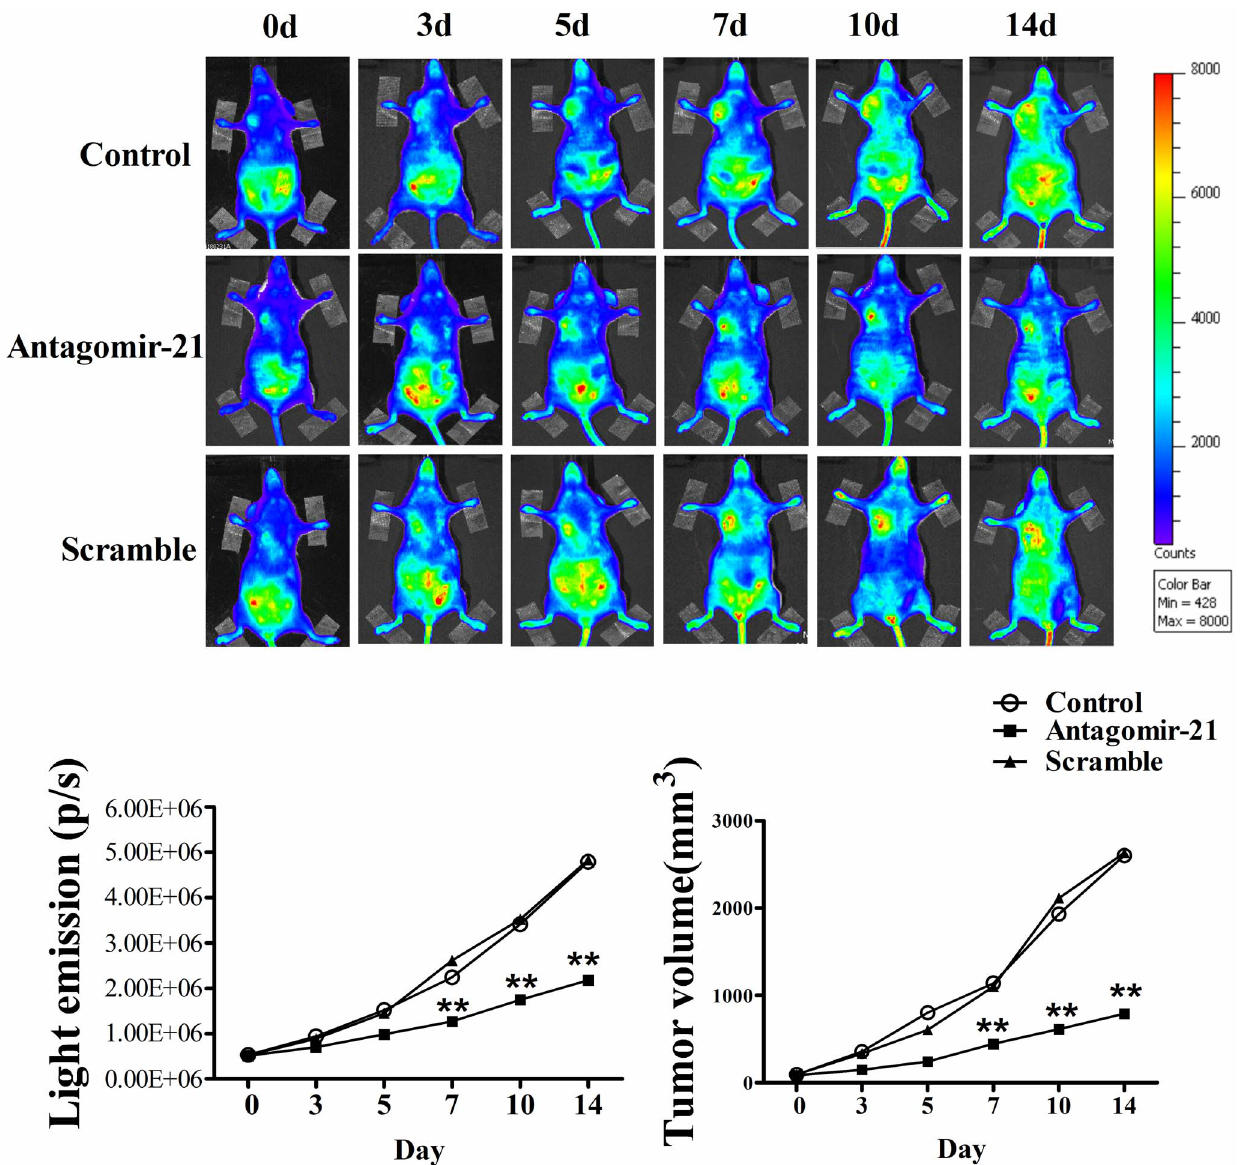
Figure 3. Bioluminescent imaging of tumor angiogenesis and change of tumor volumes. (A) Bioluminescent images of tumor-bearing mice were obtained at 0, 3, 5, 7, 10 and 14 d in the same imaging conditions. (B) The dynamic measurement of bioluminescent intensities in tumors treated with miR-21 mimic, antagomir-21 or scramble. Regions of interest (ROI) from displayed images were identified on the tumor sites and quantified as photons per second (p/s). (C) Tumor volume curves in mice treated with saline, antagomir-21 or scramble. Data are all shown as mean 6 SEM. n=5 in each group. ** P , 0.01, as compared with control.